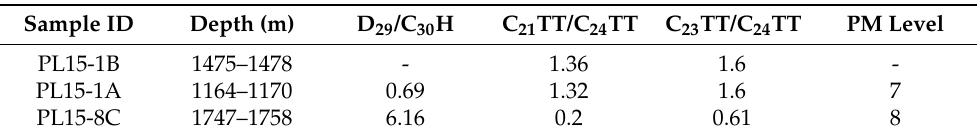
Table 1. Basic information of the studied crude oils and parameters, showing the increasing biodegra- dation levels of the samples (adapted from